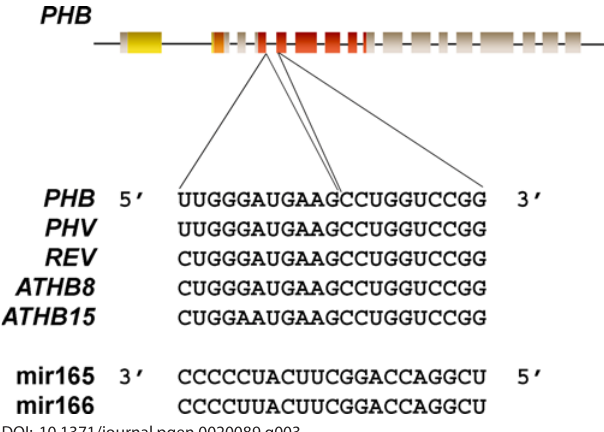
Figure 3. MicroRNAs and Class III HD–ZIP Target Sequences Diagrammatic representation of the PHB gene. Exons are represented as boxes and introns as lines. The three structural domains in the coding sequence are the HD-ZIP (yellow-orange) and the START (red) domains. Below them is the sequence of the microRNA binding site in the five Class III HD–ZIP genes and miR165 and miR166